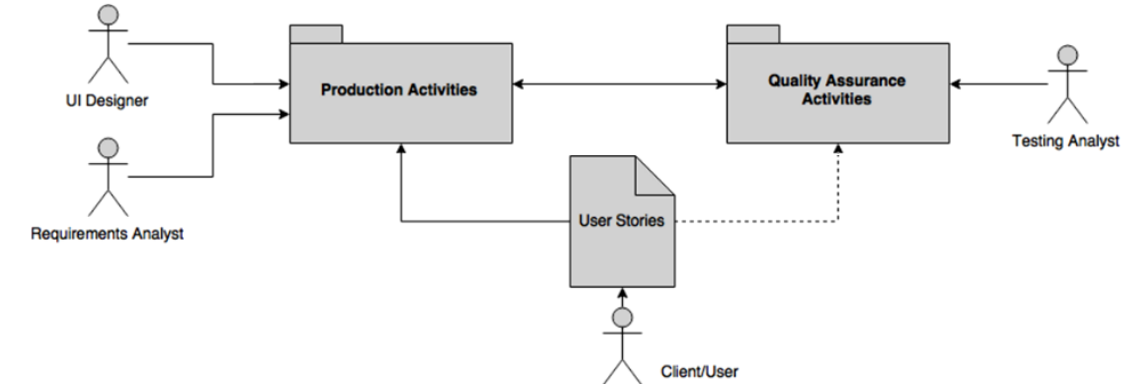
Figure 3. Overall vision of the Requirements Model